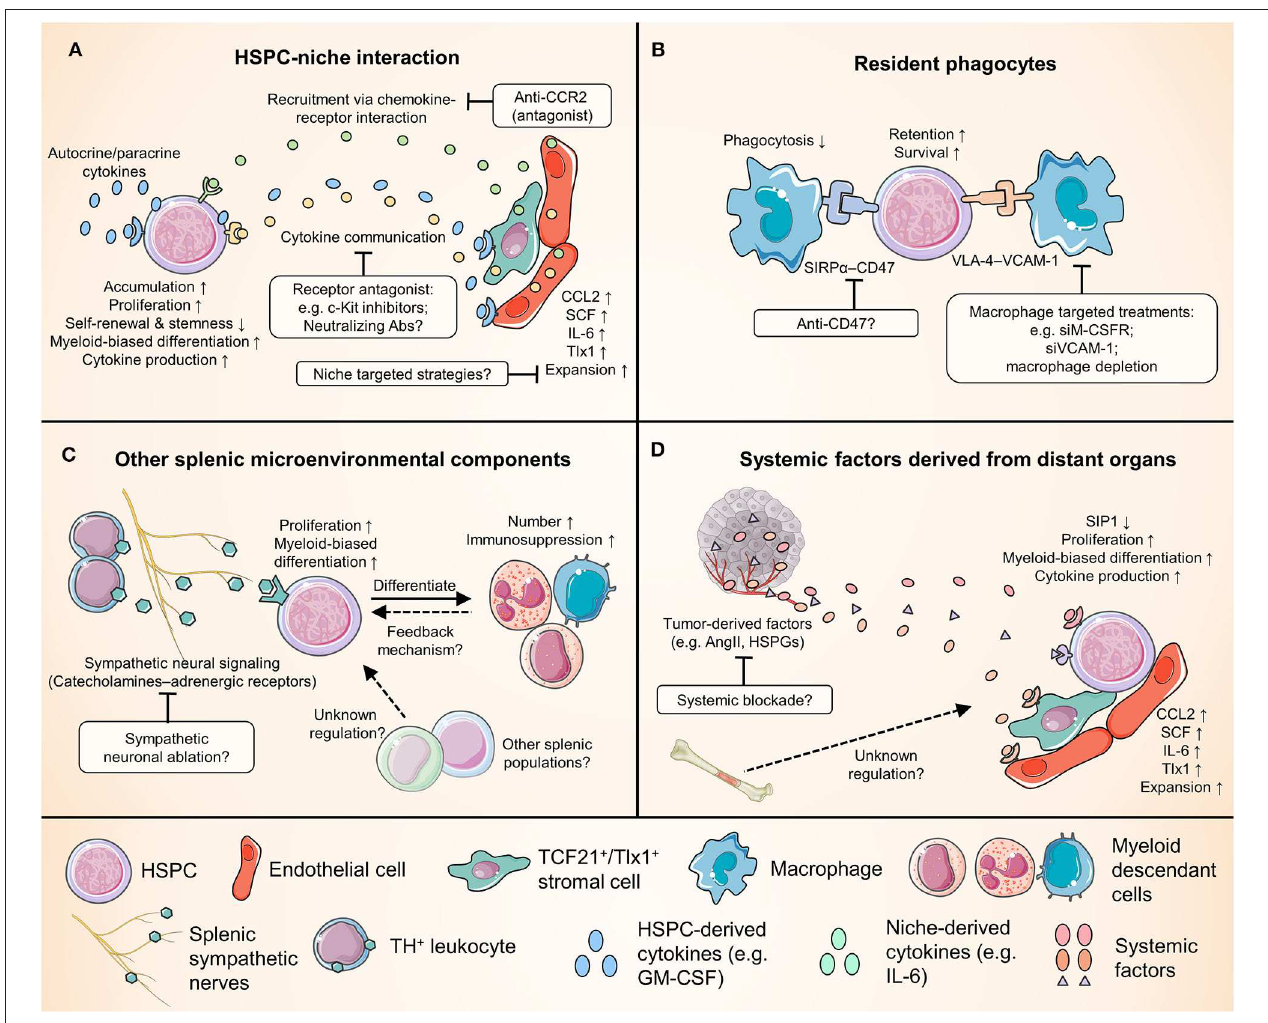
FIGURE 2 | Crucial relationships for splenic HSPCs in cancer and potential therapeutic targets. Numerous cell types and factors come into play in regulating the cancer-induced splenic HSPC activity, providing a wide range of potential therapeutic targets. This figure categorizes these interplays into four groups, and highlights examples of some potential therapies. (A) The complex reciprocal interplay between HSPCs and niche cells. (B) The interaction between HSPCs and splenic macrophages. Note that macrophages could play dual roles in modulating splenic EMH. (C) The regulation of splenic HSPC response by other splenic microenvironmental components, e.g., the sympathetic neurons and leukocytes that produce catecholamines. (D) The remote control of splenic myelopoiesis by tumor and possibly other distant organs such as the bone marrow. ACE, angiotensin-converting enzyme; AngII, angiotensin II; CCL2, C-C motif chemokine ligand 2; CCR2, C-C chemokine receptor 2; HSPGs, heparan sulfate proteoglycans; IL-6, interleukin-6; M-CSFR, macrophage colony-stimulating factor receptor; S1P1, sphingosine-1-phosphate receptor 1; SCF, stem cell factor; SIRP α , signal regulatory protein α ; Tlx1, T-cell leukemia homeobox protein 1; VCAM-1, vascular cell adhesion molecule-1; VLA4, very late